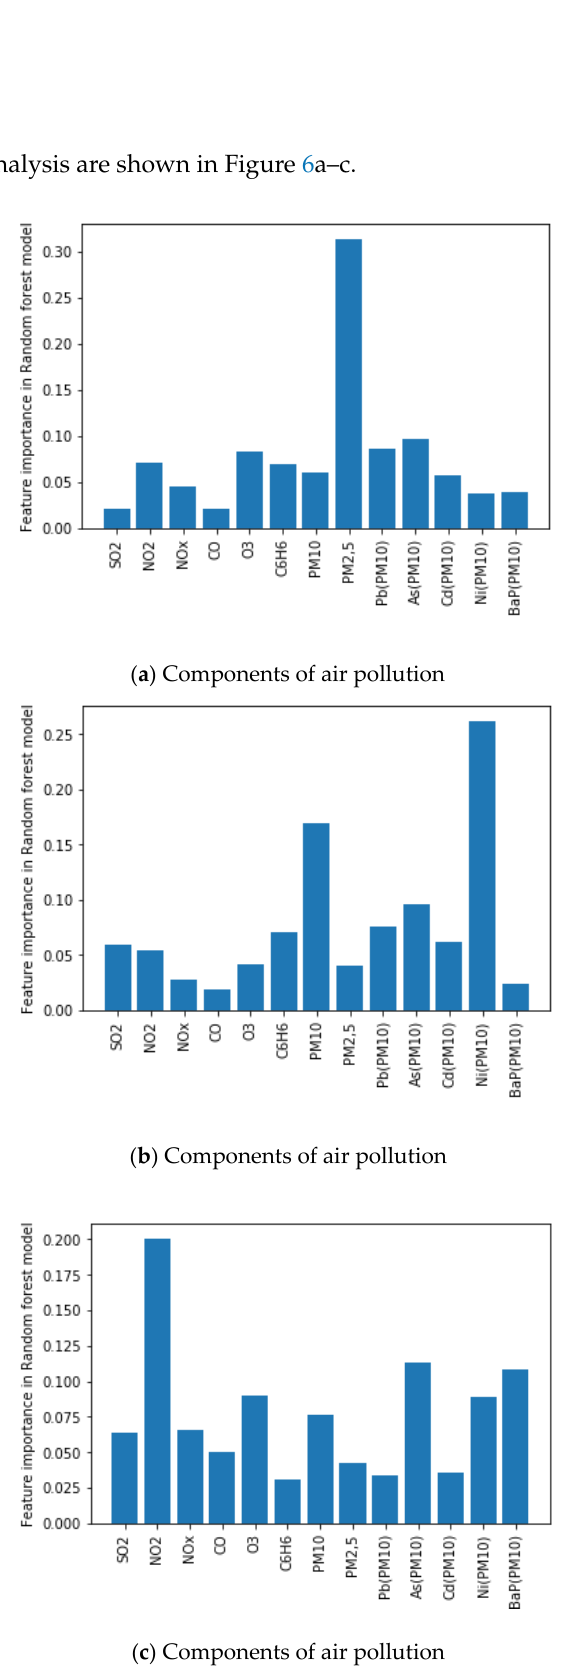
Figure 6. The importance of parameters (types of pollutants) in the random forest regresson model when analyzing the causes of diseases ( a ) C34 (malignant neoplasm of bronchus and lung), ( b ) C17 (malignant neoplasm of the small intestine), and ( c ) C18 (malignant neoplasm of the large intestine).